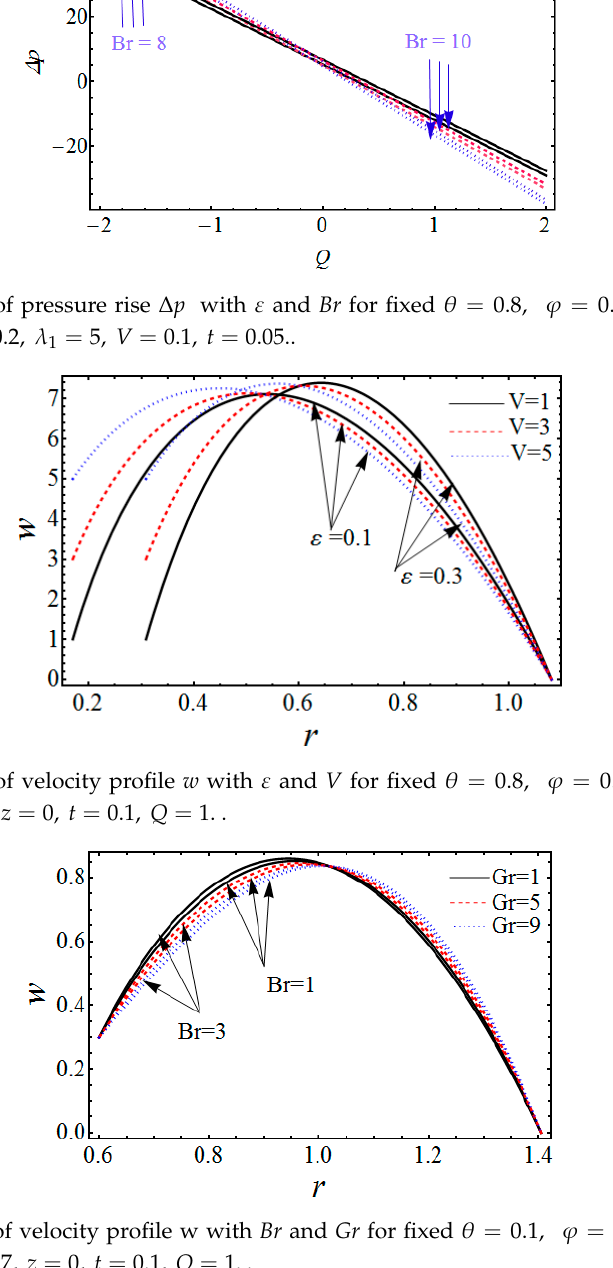
. Figure 8. Variation of velocity profile w with Br and Gr for fixed θ = 0.1, ϕ = 0.5, δ = 0.5, ε = Figure 8. Variation of velocity profile w with 𝐵𝑟 and 𝐺𝑟 for fixed 𝜃 = 0.1, 𝜑 = 0.5, 𝛿 = 0.5,𝜀 = 0.1, V = 0.3, λ 1 = 0.7, z = 0, t = 0.1, Q = 1. 0.1, 𝑉 = 0.3, 𝜆 (cid:2869) = 0.7, 𝑧 = 0, 𝑡 = 0.1, 𝑄 = 1.